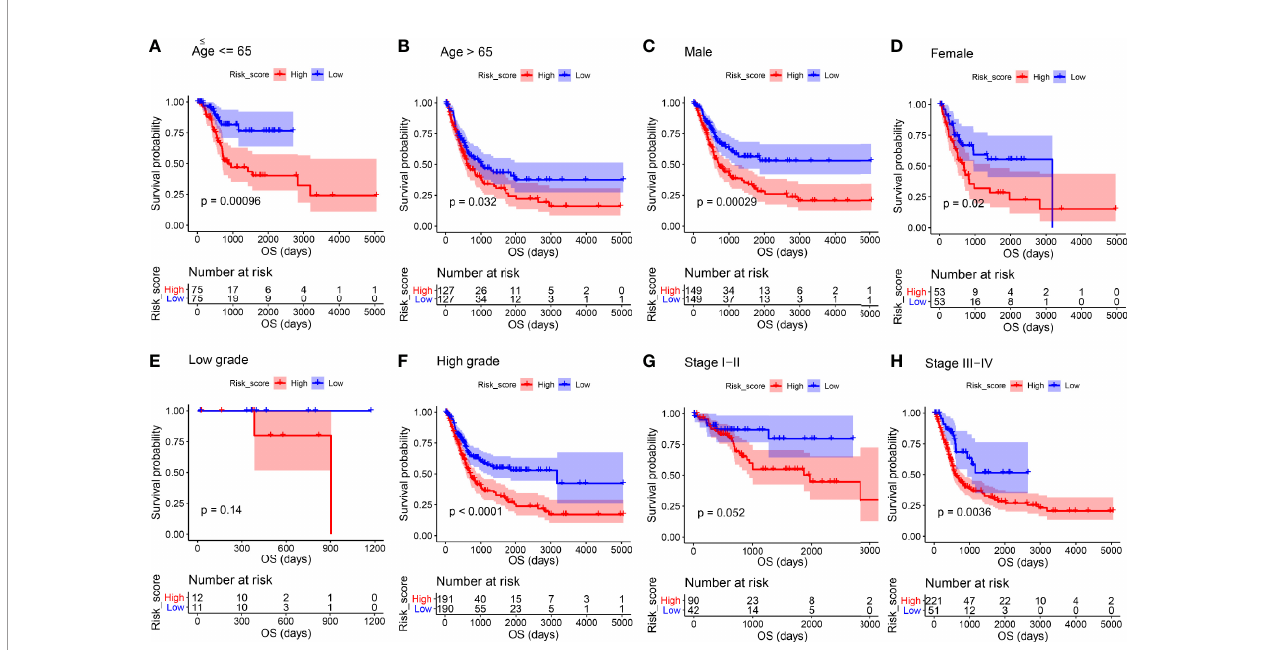
FIGURE 5 | Kaplan-Meier overall survival curves for the high- and low-risk groups strati fi ed by clinicopathological variables. (A, B) Age. (C, D) Gender. (E, F) Grade. (G, H) Stage.